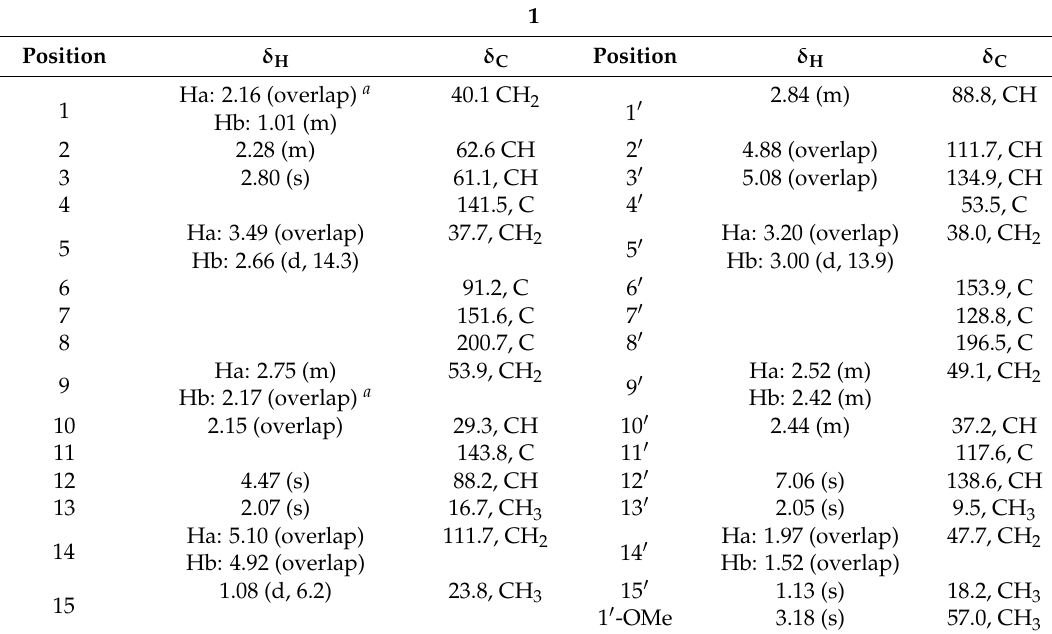
Table 1. 1 H- (800 MHz) and 13 C-NMR (200 MHz) data of 1 in CDCl 3 ( δ in ppm, J in Hz).